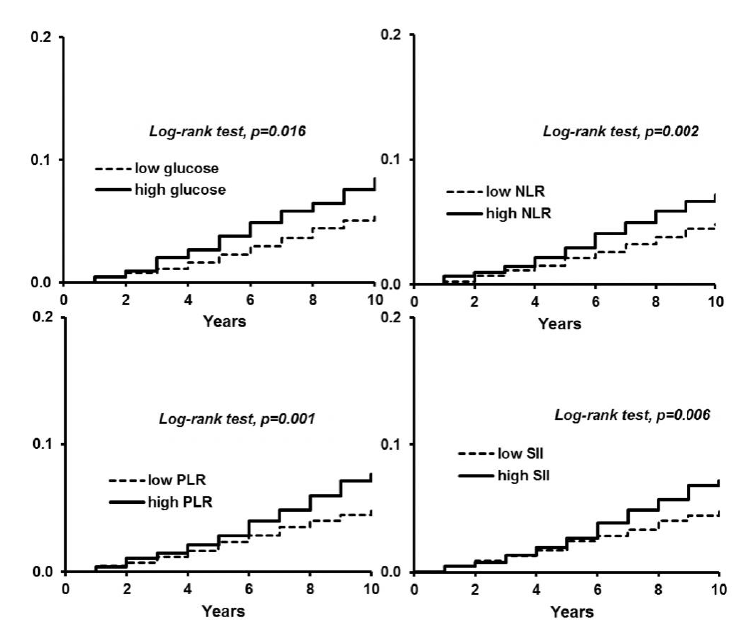
Figure 3. 1–cancer-free survival and p -value for the logrank test for glucose, NLR, PLR, and SII. Table 3 shows the adjusted HR for cancer diagnosis associated with MS, NLR, PLR, and SII. Patients ’ age was significantly associated with the HR for cancer diagnosis in all models. Gender, smoking, physical activity, and education, conversely, did not contribute significantly to their likelihood. An NLR ≥ 1.5, a PLR ≥ 110.6 , and a SII ≥ 365,776 were positively associated with the adjusted HR for cancer diagnosis. A high level of glucose exhibited a positive association of borderline significance with the adjusted HR for cancer diagnosis. Table 3. Adjusted hazard ratio for cancer diagnosis associated with MS, NLR, PLR, SII, and with individual components of the metabolic syndrome.